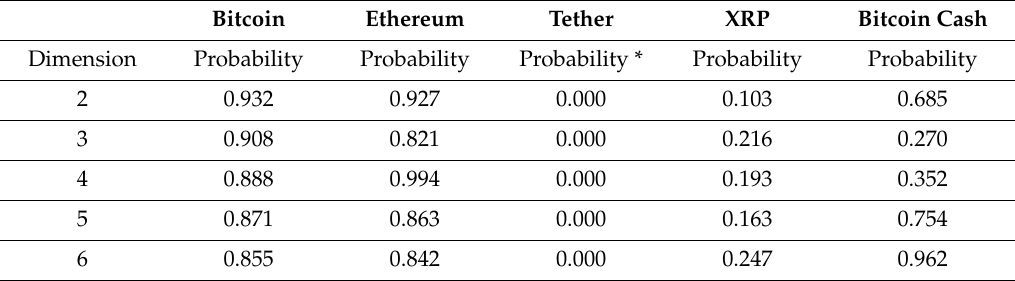
Table 2. Augmented Dickey-Fuller test to check unit root presence. Table 3. Brock, Dechert, Scheinkman and LeBaron (BDS) test of